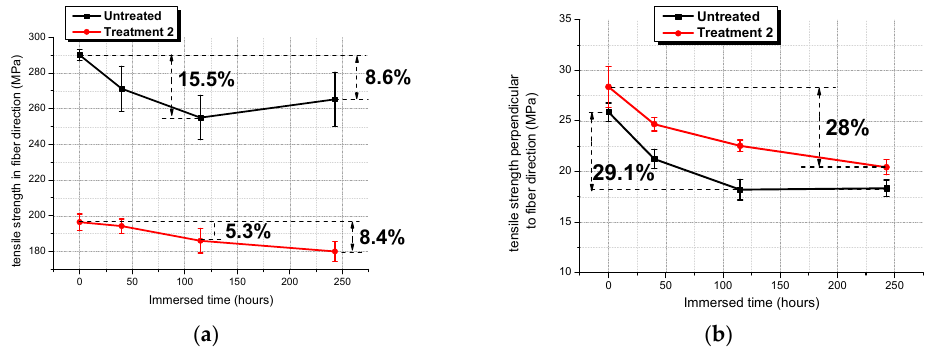
Figure 8. Comparison of retention rates in tensile strength after water uptake: ( a ) comparison of longitudinal tensile strength between treated and untreated composites; and ( b ) comparison of transverse tensile strength between treated and untreated composites. (Error bars indicate standard